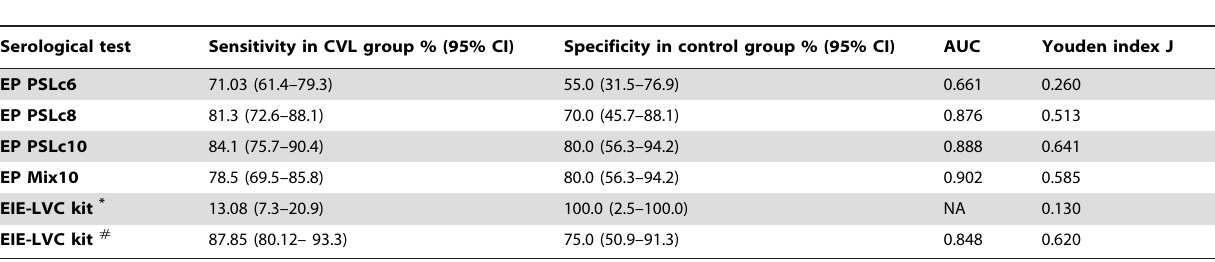
Table 2. Diagnostic performance of EP and EIE-LVC kit in a larger panel of canine serum samples.